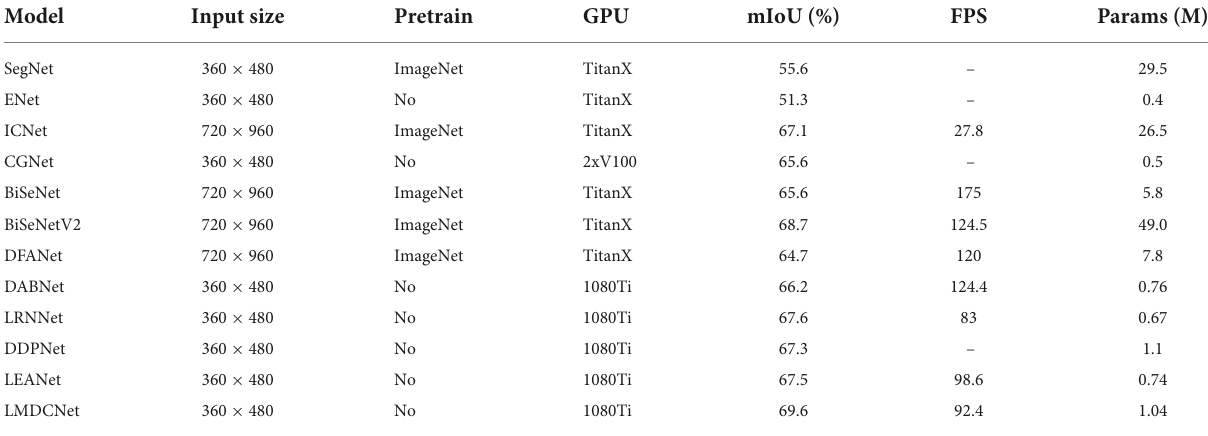
TABLE 6 Evaluation results of our lightweight multi-dimensional dynamic convolutional network (LMDCNet) and other state-of-the-art real-time semantic segmentation models on the CamVid test set. Model